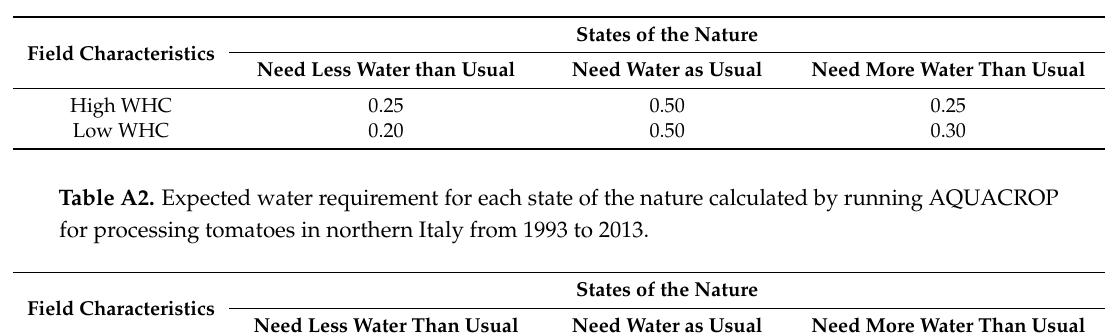
Table A1. Probability of states occurrence calculated by running AQUACROP for processing tomatoes in northern Italy from 1993 to 2013.